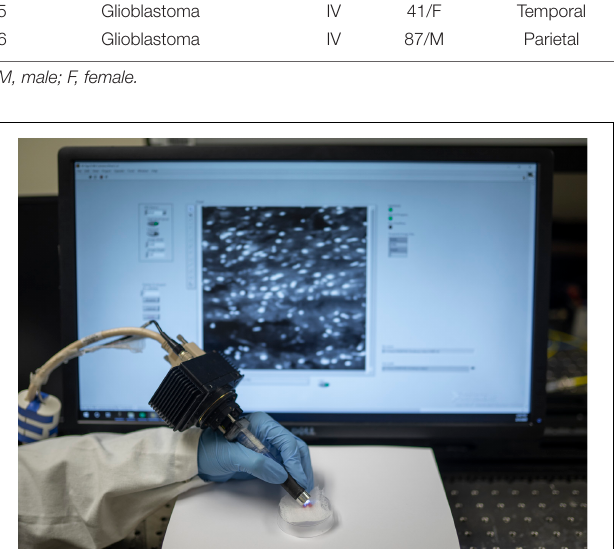
FIGURE 1 | Hand-held dual-axis confocal (DAC) microscope system. As described in a previous publication [L. Wei et al., Opt. Lett. , 2019], the DAC microscope allows for high-speed (16 frames/sec) optical-sectioning fluorescence microscopy of intact thick tissues. The spatial resolution of the images is at the subnuclear scale ( ∼ 1 µ m lateral, ∼ 2 µ m axial), and the field of view of each image frame is ∼ 350 × 350 µ m. Interchangeable lens caps enable fixed imaging depths at up to ∼ 150 microns beneath the tissue